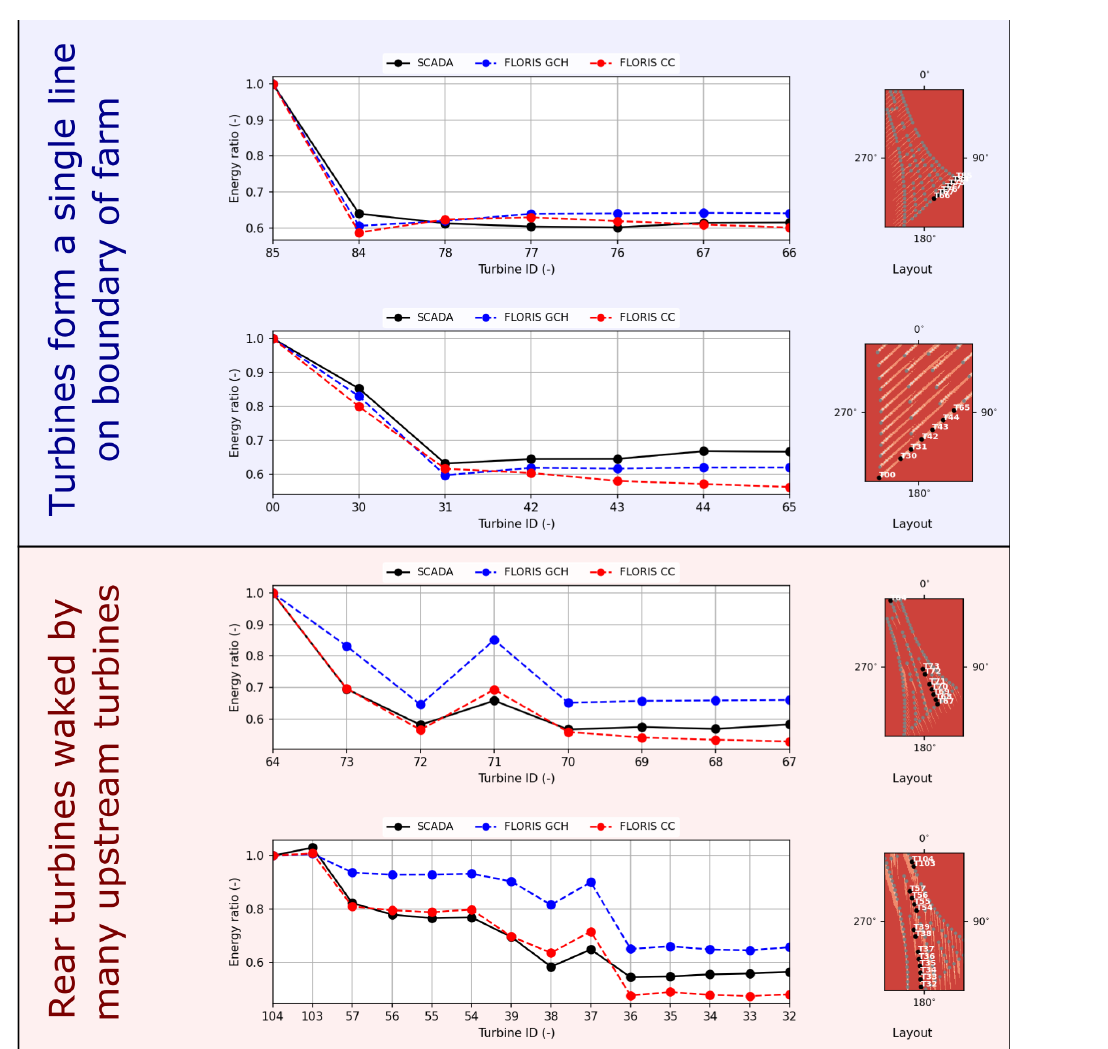
Figure 10. Ratio of energy produced by wind turbines in a row with respect to the energy produced by the first turbine in the row. The energy ratios are normalized to the most upstream wind turbine in the row. The wind direction used to bin the data is assumed to be equal to the nacelle heading of the most upstream wind turbine. The four turbine arrays considered are all from the Anholt wind farm, which is an excellent candidate for these validation studies because of its sheer size (111 wind turbines). The layout of the Anholt farm is shown on the right of each plot, with the turbine IDs highlighted for each